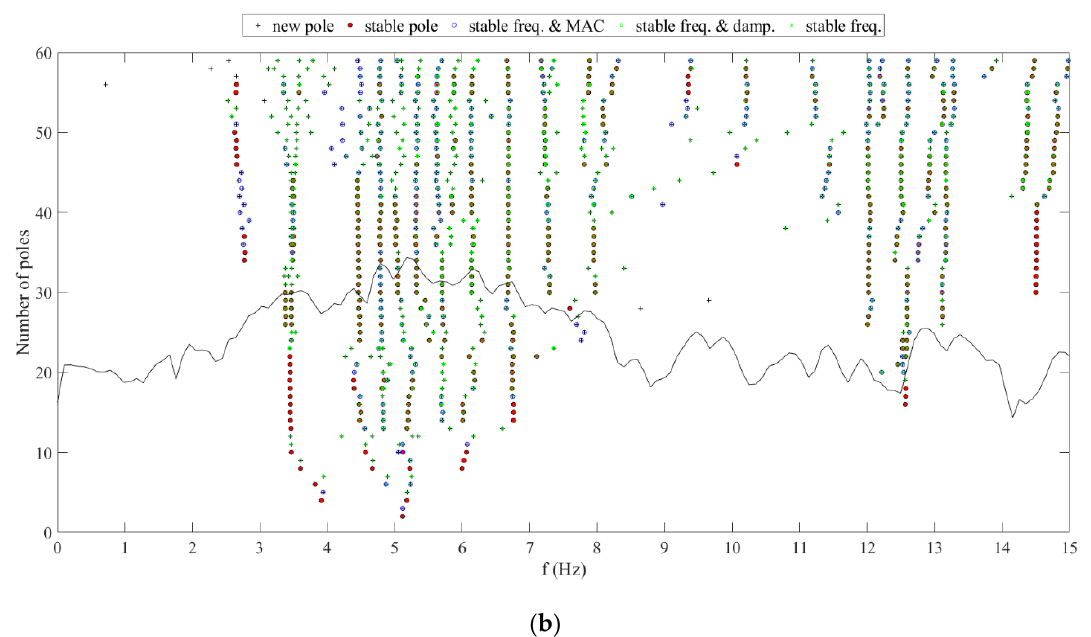
Figure 6. Stabilization diagram corresponding to different methods of modal identification in the San Fernando earthquake in 2001: ( a ) ERA-OKID-OO method; ( b ) N4SID-OO method.